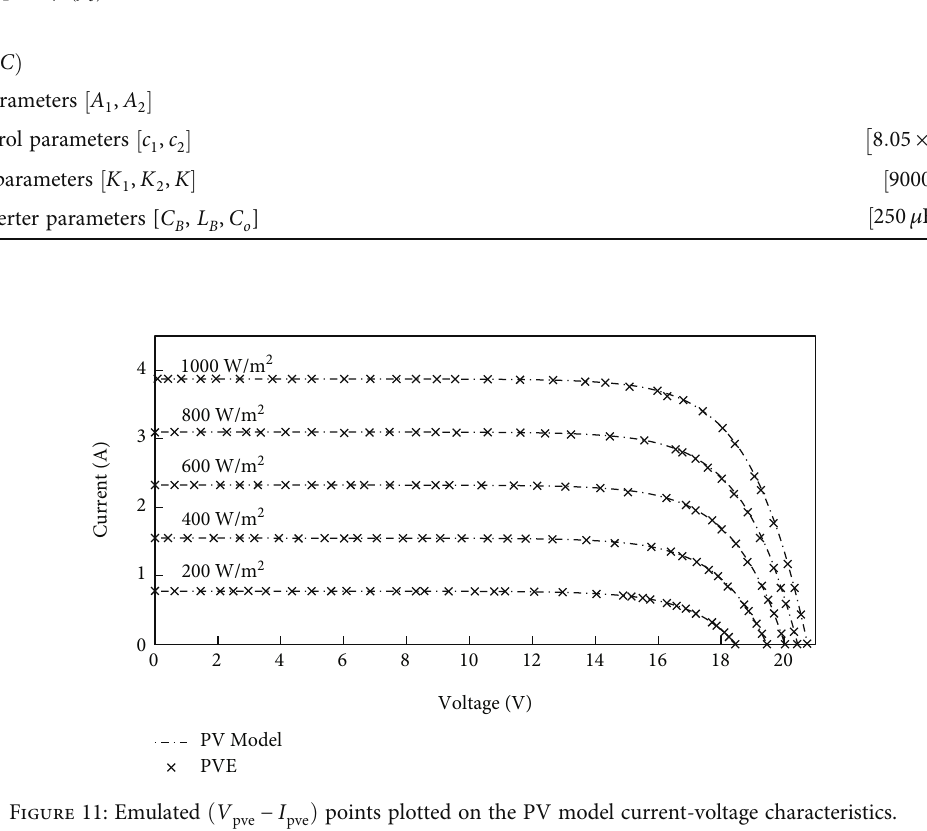
Figure 11: Emulated ð V